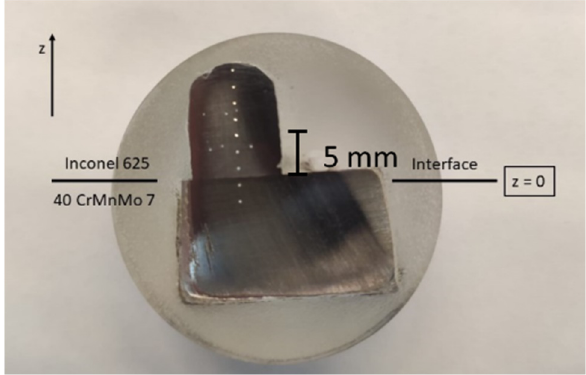
Figure 6. Hardness measurements on a specimen [17].